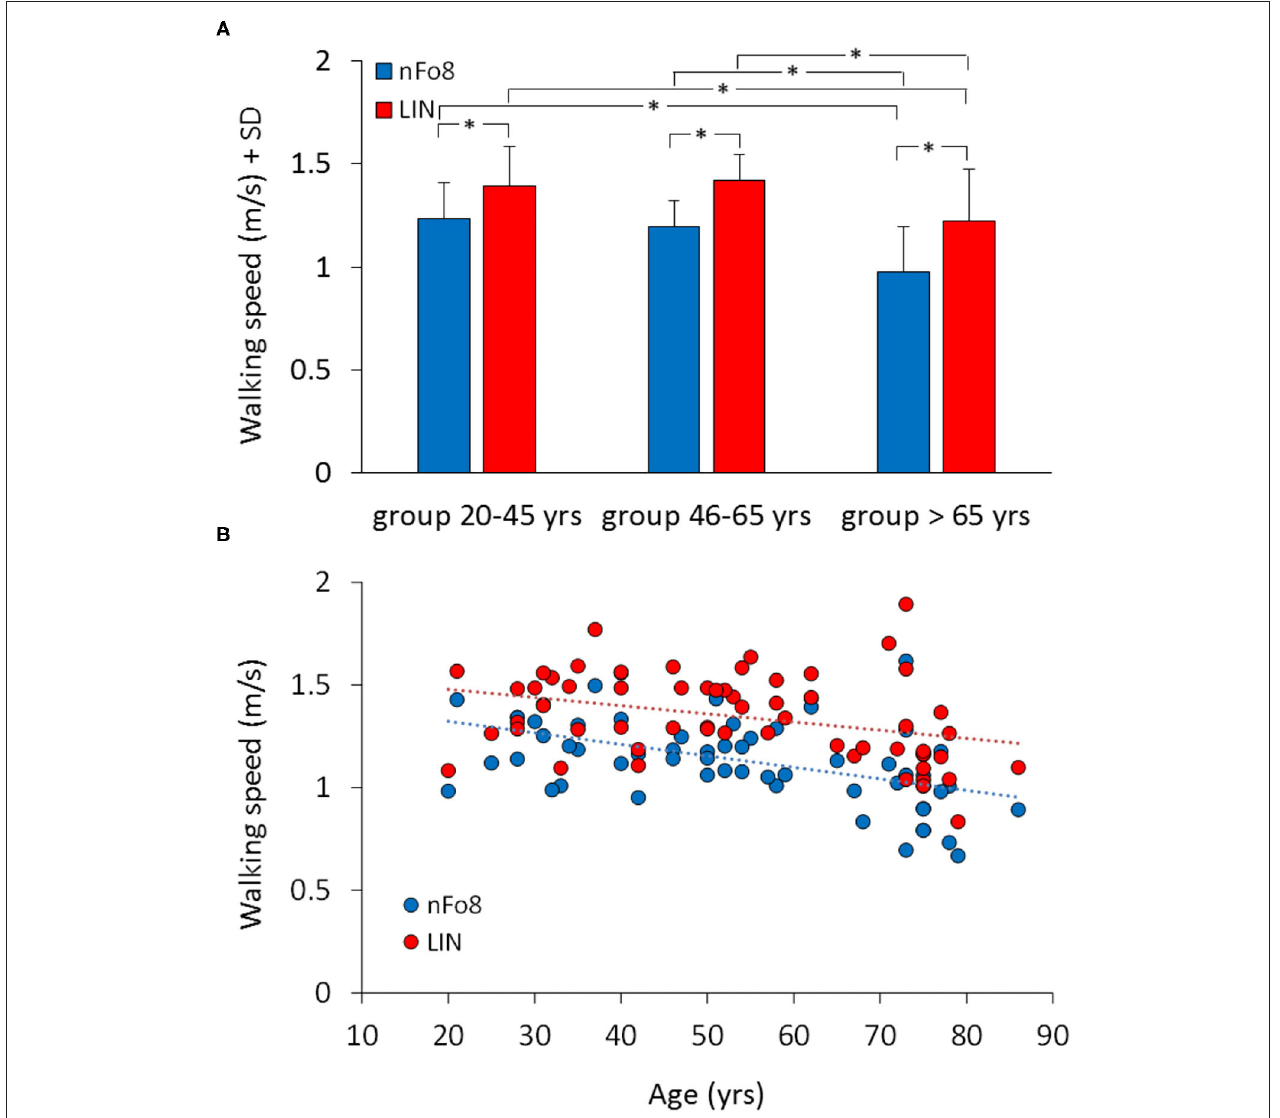
FIGURE 2 | Mean walking speed of the three age groups (A) and the relationship between walking speed and age across all participants (B) . Blue bars and dots refer to the nFo8, red bars and dots refer to LIN. In all the three age groups, speed was lower during nFo8 than during linear walking. Gait was slower in oldest group than in the young and middle-age group under both walking conditions. Asterisks indicate significant